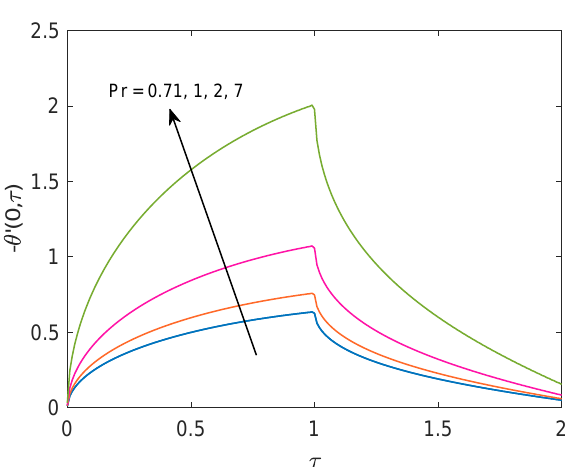
Figure 15. Effect of different values of τ .